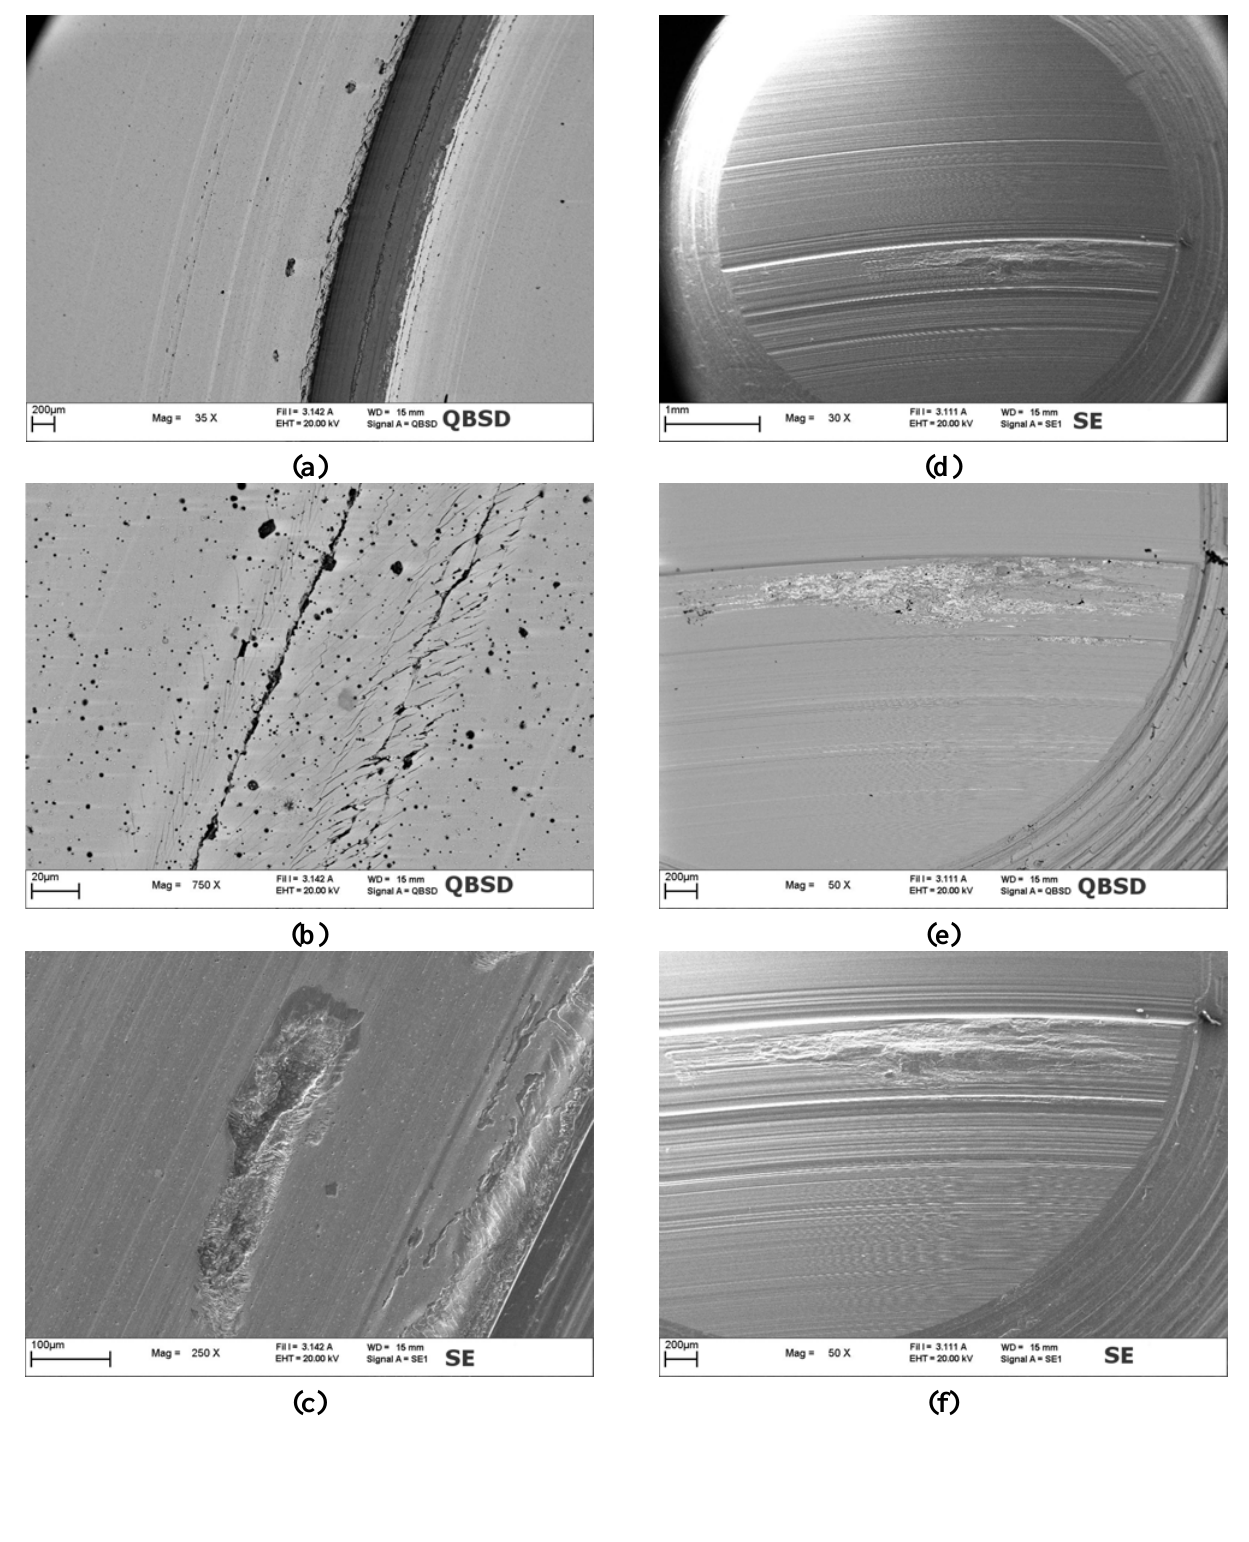
Figure 12. SEM micrographs of the WC/C coated disc and of the counterpart pin after 1000 m of sliding distance: ( a ), ( b ) and ( c ) large view and details of the wear track on coated disc; ( d ), ( e ) and ( f ) large view and details of the counterpart worn